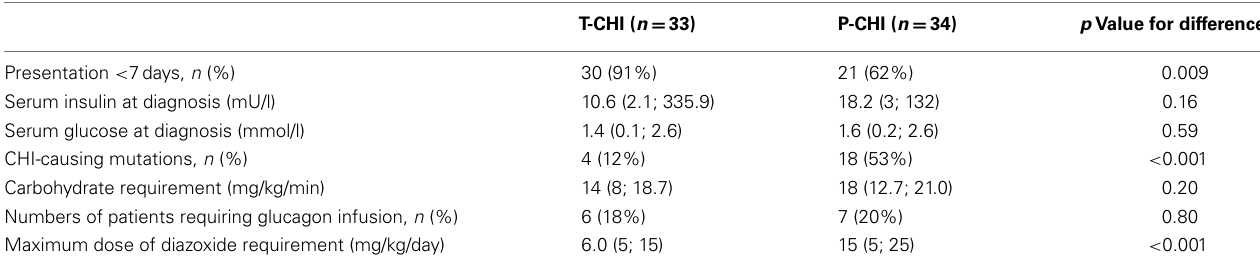
Table 1 | Diagnostic and treatment characteristics of children withT-CHI and P-CHI: categorical variables are represented as numbers of patients and as a percentage (%) of the cohort, while continuous variables are represented as median (range) values.